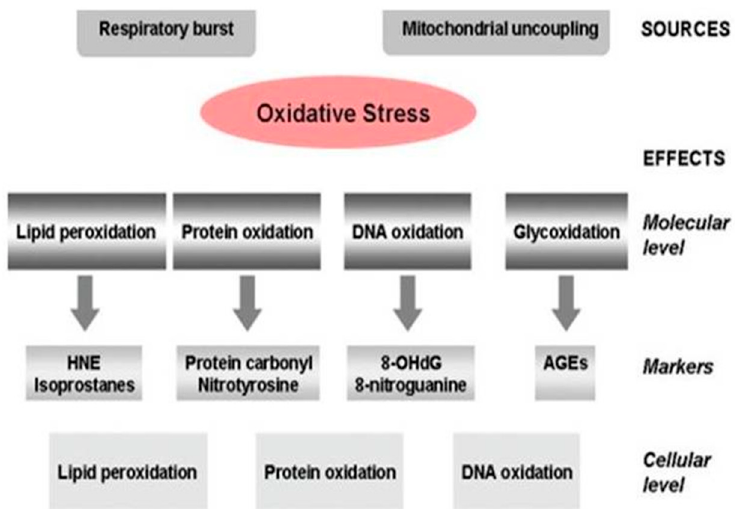
Figure 2. Oxidative stress sources and effects at the molecular and cellular levels, as well as their corresponding markers